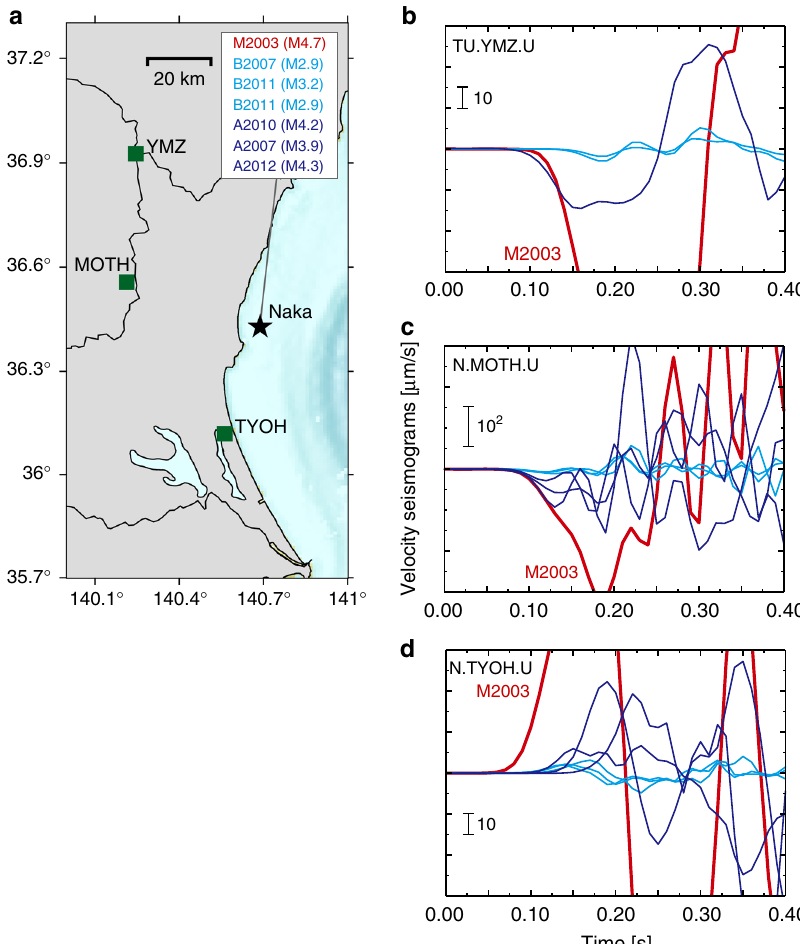
Fig. 4 Seismogram comparison between the M2003 ( M 4.7) earthquake and smaller group A earthquakes. a Map showing the locations of stations (squares) used in the waveform comparison, relative to the Naka events (star). Waveform comparison at each station: b TU.YMZ. c N.MOTH. d N.TYOH. The vertical components of the raw seismograms are shown here. The traces are plotted to align the onsets of the P-waves. The seismograms are neither fi ltered nor normalised. The relative arrival time differences at each station are